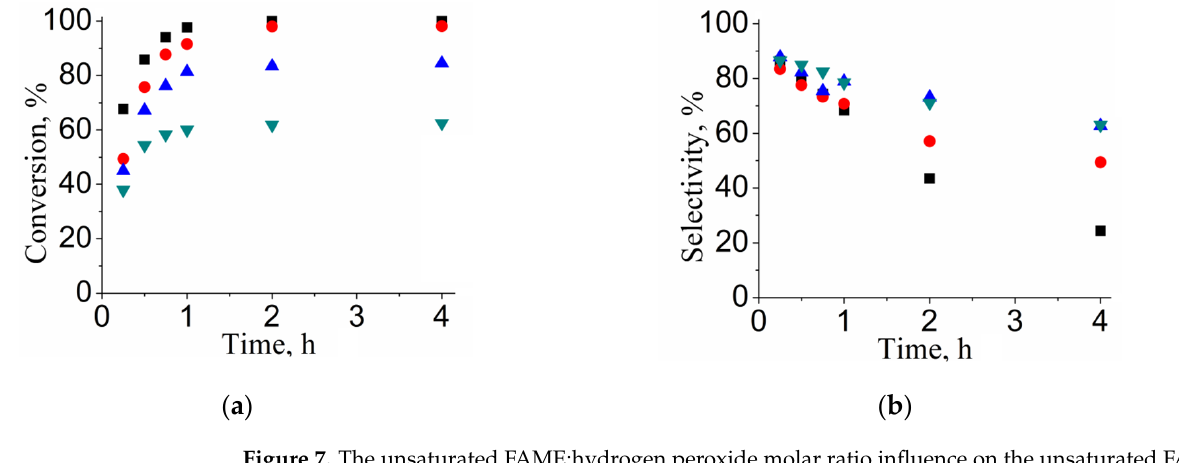
Table 5. The results of hot filtration test for the PW4@MIL-100(Cr) catalyst. Conversion (%) Time (h) (FAME:H 2 O 2 Molar Ratio of 1:2) *